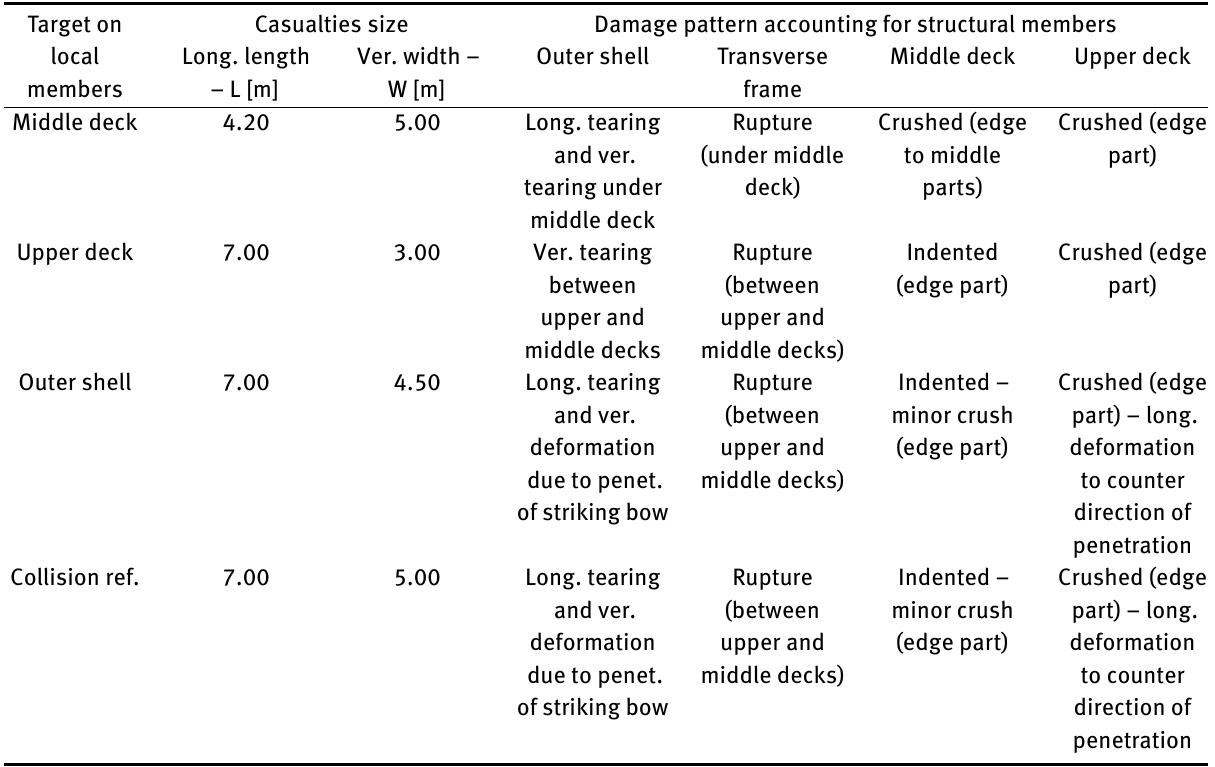
Table 1: Summary of the damage pattern of the analyzed collision problems Target